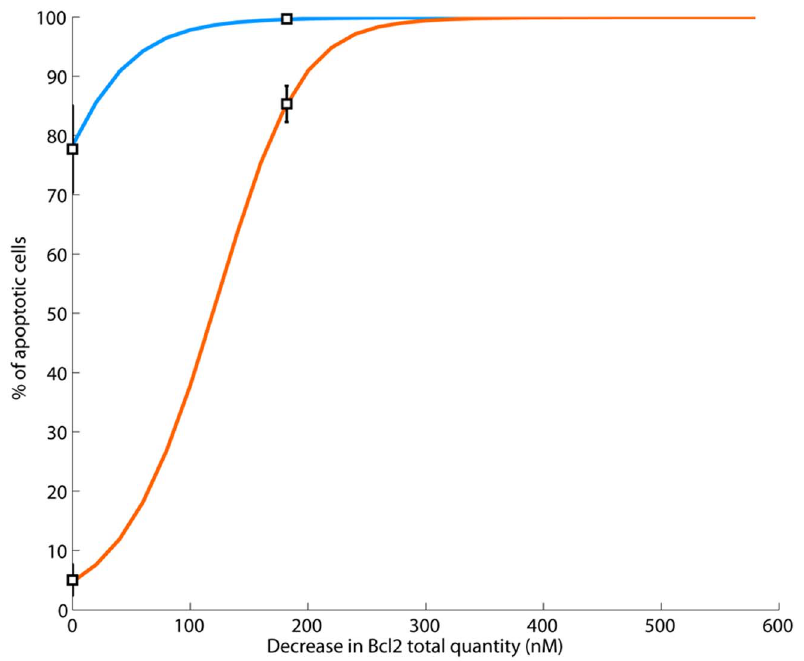
Figure 8. Simulated cell death after staurosporine exposure and preincubation with ABT-737, in parental (blue) and Src- transformed (orange) NIH-3T3 cells. Anti-apoptotic inhibitors such as ABT-737 was modeled as a decrease in the amount of Bcl2 molecules. For any dose of inhibitors, i.e. any decrease of Bcl2 total quantity, simulated apoptosis was greater in parental fibroblasts compared to Src-transformed cells. Moreover, only the administration of high doses managed to circumvent resistance of transformed cells which also induced an extremely high toxicity. the parental fibroblasts population (Figure 6). Those data points were reproduced by the calibrated mathematical model for a predictive decrease of 182 nM in Bcl2 total concentrations in both cell types.